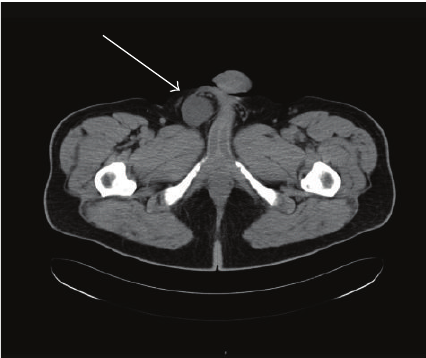
Figure 3: CT scan showing the solid soft-tissue paratesticular mass in contact with the right spermatic cord (white arrow).